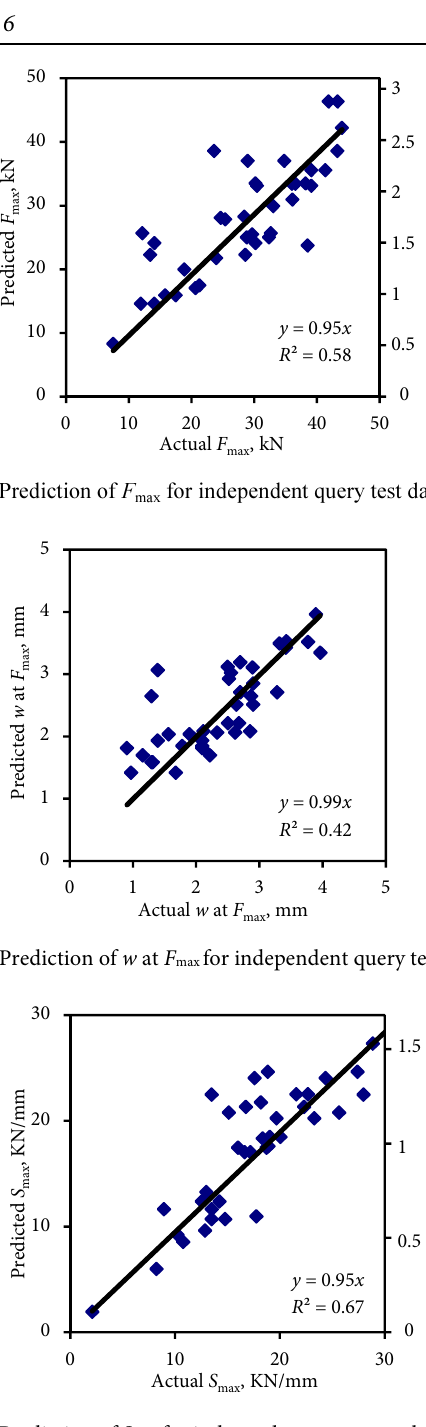
Fig. 9. Prediction of S max for independent query test dataset For the linear regression the findings are similar. For all regression lines a slope very close to 1 is found, alt- hough the linear regression coefficients R 2 are not high. F and S they receive values of 0.66 for training For max max and 0.72 for testing. In case of the shear deformation at F , R 2 is very low (0.09 for training and 0.22 for testing). max It is interesting to note, that in the LTPP data, as opposed to the New Road data, a weak correlation for the F can be found. This max shear deformation at max